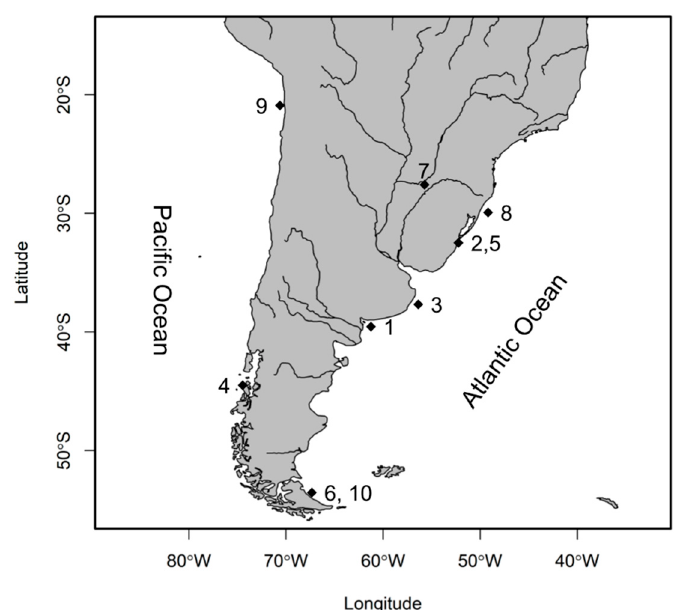
Figure 1. Location of collection sites of Odontesthes specimens in South America. 1: O. argentinensis , 2: O. humensis , 3: O. incisa , 4: O. mauleanum , 5: O. mirinensis , 6: O. nigricans , 7: O. perugiae , 8: O. piquava , 9: O. regia , and 10: O. smitti . Table 1. Information on the location and type of environment of the collection sites, number and sex of specimens analyzed in this study.